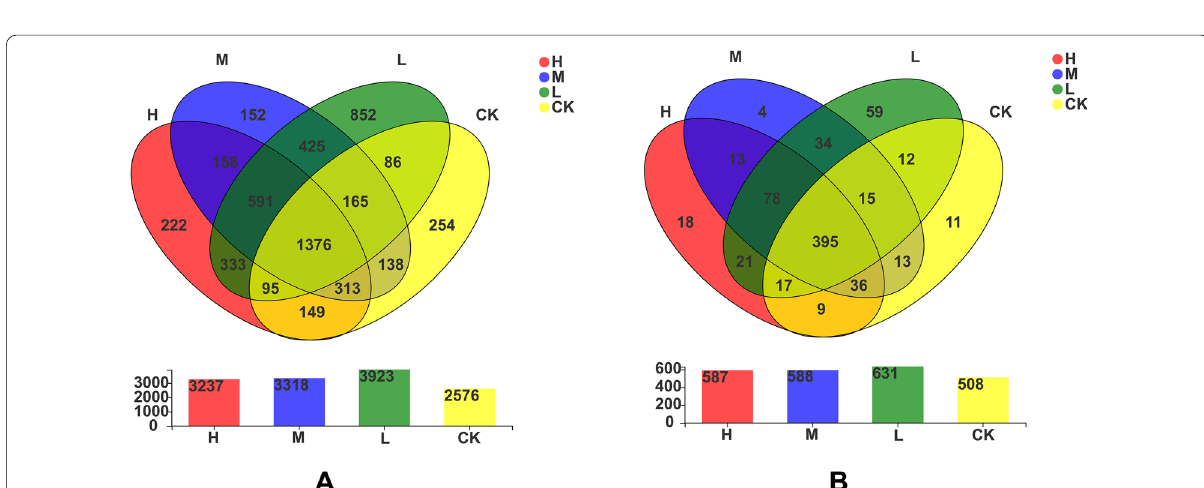
Fig. 3 Venn analysis of soil bacteria in sugarcane fields under four N application treatments at the OTU ( A ) and genus ( B ) levels. H: high N application in the sugarcane soil (964 kg ha − 1 ), M: medium N application in the sugarcane soil (482 kg ha − 1 ), L: low N application in the sugarcane soil (96 kg ha − 1 ), CK: no N application in the sugarcane soil (0 kg ha − 1